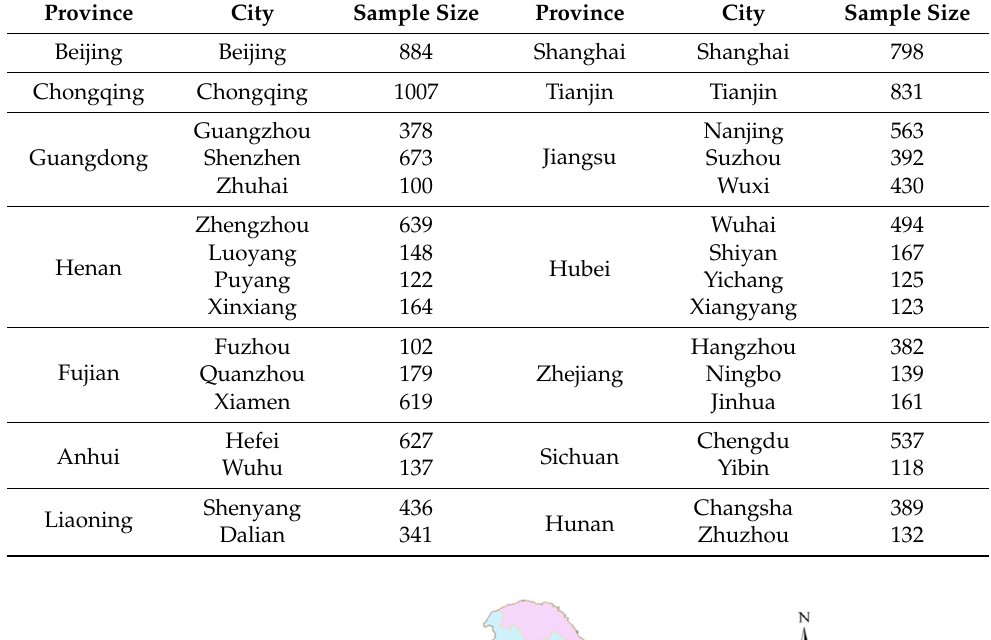
Table 1. Research samples from major cities (PPS method).